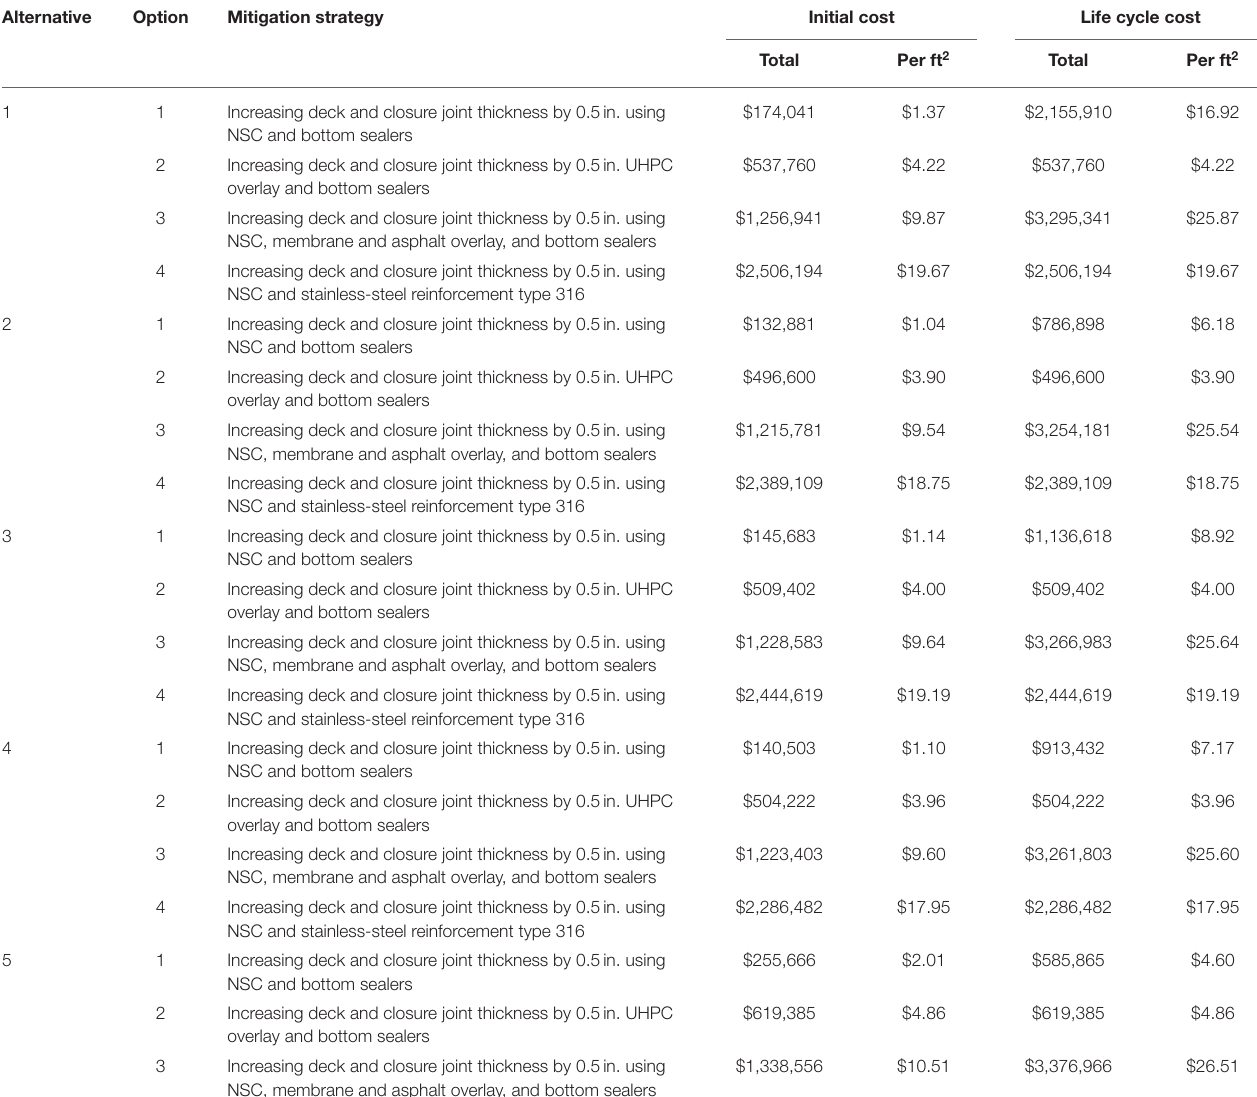
TABLE 8 | Life cycle cost analysis for alternative–option.